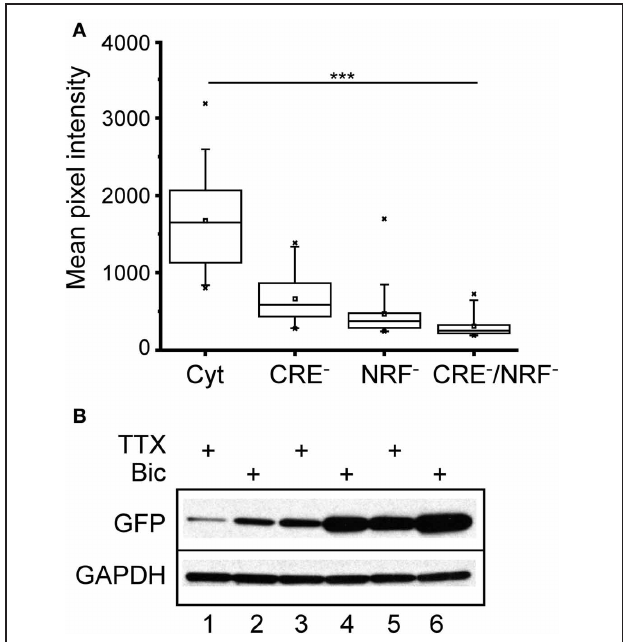
FIGURE 6 | Cycs enhancer-driven GFP expression in hippocampal neurons requires intact CREB and NRF1 binding sites. (A) Box and whisker plots showing the relative levels of steady state GFP expression in neurons infected with reporter viruses containing mutations in the CREB or NRF1 binding sites or both. Images of a least 25 cells in 10 fields were analyzed. Mean pixel intensities are in arbitrary units. Between group statistical significance was determined using the paired sample Wilcoxon signed rank test, ∗∗∗ p < 0 . 001. (B) Western blot showing effect of bicuculline and TTX on mutated enhancers. NRF1 − enhancer (48h TTX), NRF1 − enhancer (48h bicuculline), CRE − enhancer (48h TTX), CRE − enhancer (48h bicuculline), intact enhancer (48h TTX); intact enhancer (48h bicuculline). Glyceraldehyde-3-phosphate dehydrogenase (GAPDH) was used as a loading control.